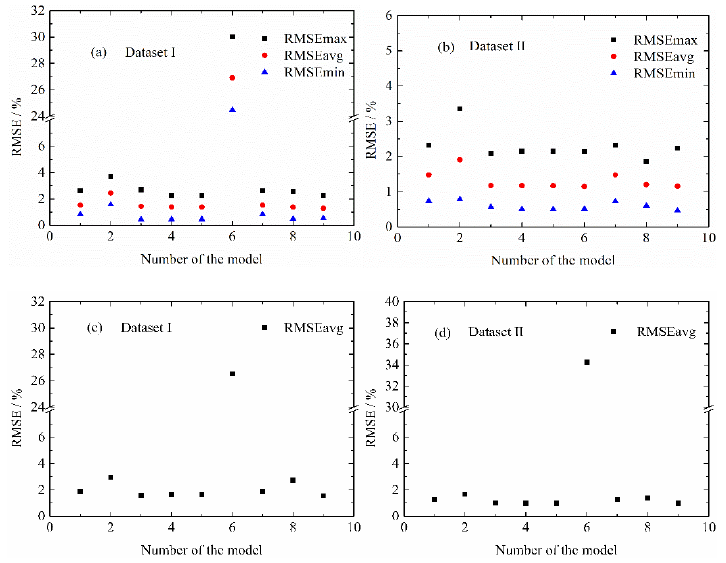
Figure 4. Prediction RMSE of the non-factor models for normal aging: ( a ) on the train dataset of Dataset Ⅰ, ( b ) on the train dataset of Dataset Ⅱ, ( c ) on the test dataset of Dataset Ⅰ and ( d ) on the test dataset of Dataset Ⅱ . Dataset I, ( b ) on the train dataset of Dataset II, ( c ) on the test dataset of Dataset I and ( d ) on the test dataset of Dataset